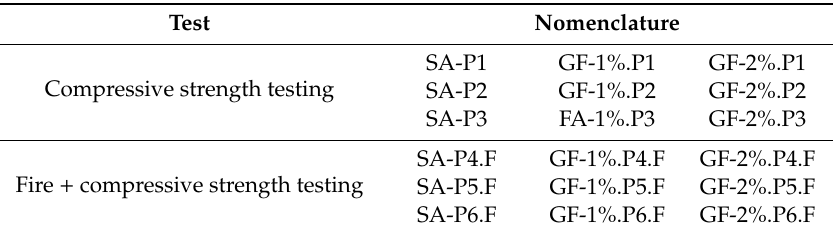
Table 3. Nomenclature and tests performed on the mass concrete test pieces.